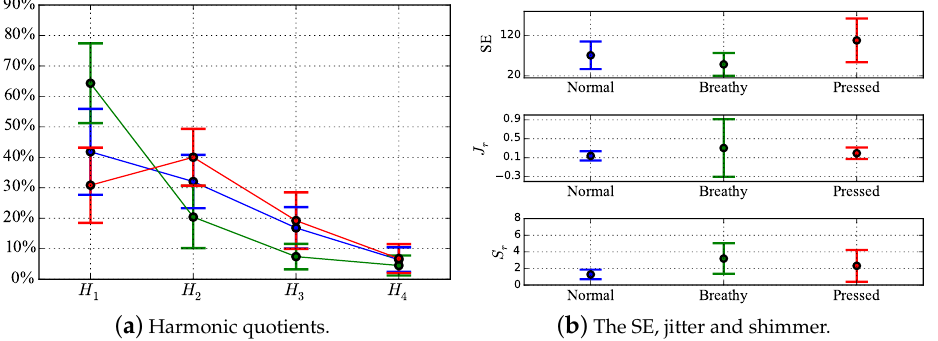
Figure 4. Representative example of normalized NSA waveforms and corresponding spectra of /a:/ in terms of different voice types: modal, breathy and pressed. The frequency resolution is 1 Hz.